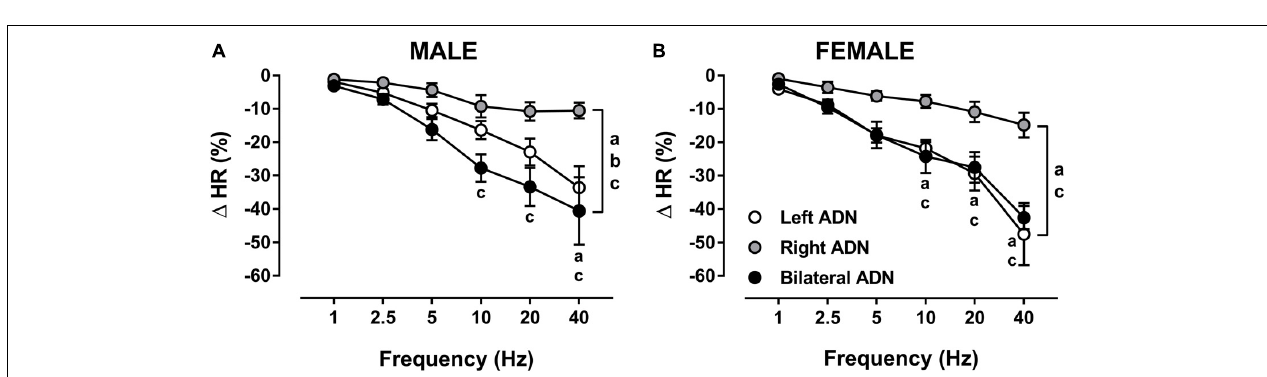
FIGURE 4 | Effects of left, right and bilateral aortic depressor nerve (ADN) stimulation (1–40 Hz, 0.4 mA, 0.2 ms, 20 s) on heart rate (HR) responses in urethane-anesthetized male (A) and female (B) Sprague Dawley (SD) rats ( n = 7–11). Results are expressed as mean ± SEM. a P ≤ 0.05, left vs. right ADN, b P ≤ 0.05, left vs. bilateral ADN and c P ≤ 0.05, right vs. bilateral ADN analyzed by a two-way ANOVA followed by Bonferroni’s post hoc . Note that bilateral stimulation in males and both left and bilateral stimulation in females evoked the highest drops in HR (both overall and at frequencies above 5 Hz).